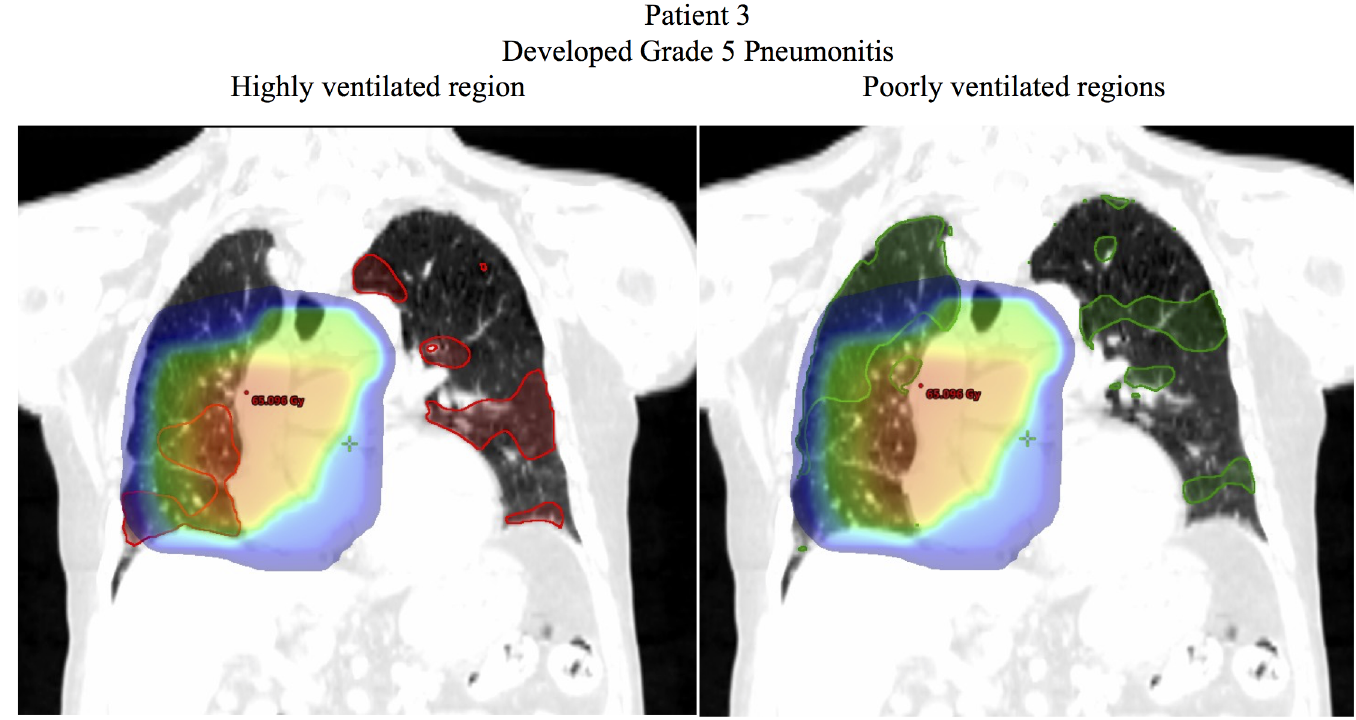
Fig 7. Example case of a patient with severe radiation pneumonitis (Grade 5). The red contour indicates the highly ventilated region (70th–100th percentiles) and the green contour indicates the poorly ventilated region (0–30th percentiles). The dose > 5 Gy is shown. In this patient, there was no clear association between the ventilation-based dosimetric parameters and the ventilation state of the